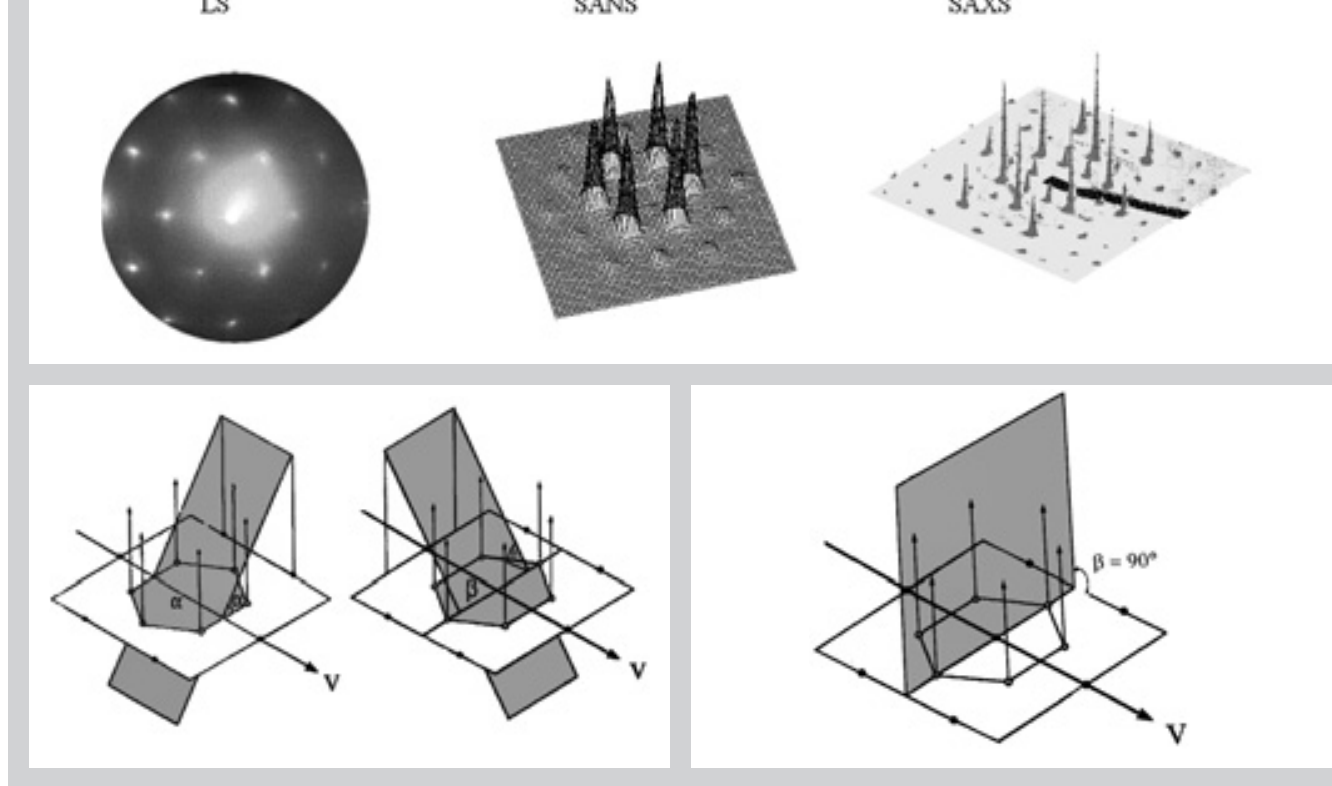
Figure 4: LS, SANS, and SAXS scatter- ing at perpendicular inci- dence to h, k layers. Figure 5: a and b -rotation of the Ewald planes. Figure 6: b = 90 ∞ for tangential